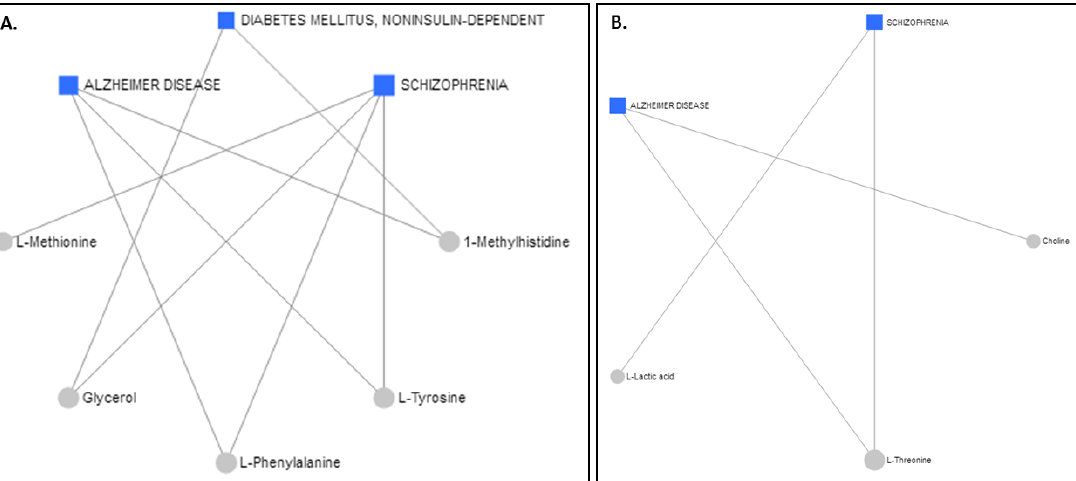
Figure 6. Schematic diagram illustrating disease-related metabolites and relevant pathways based on the metabolite data from ( A ) serum and ( B ) colostrum.